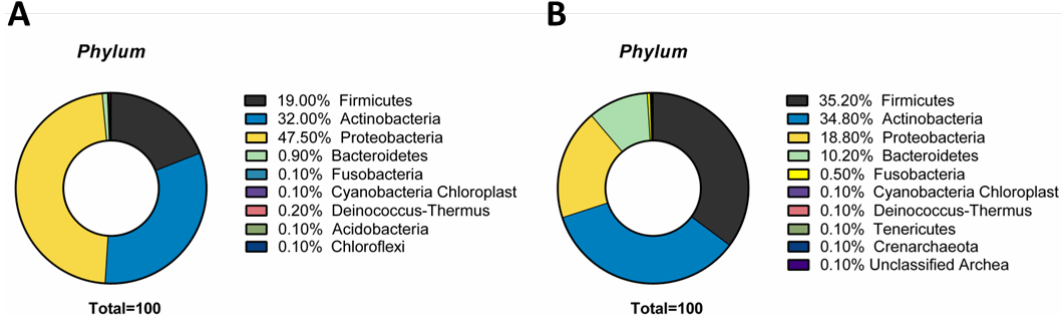
Figure 1. ( A ) Phylum of conjunctival samples performed at birth and ( B ) after antibiotic prophylaxis ( p -value < 0.0001).